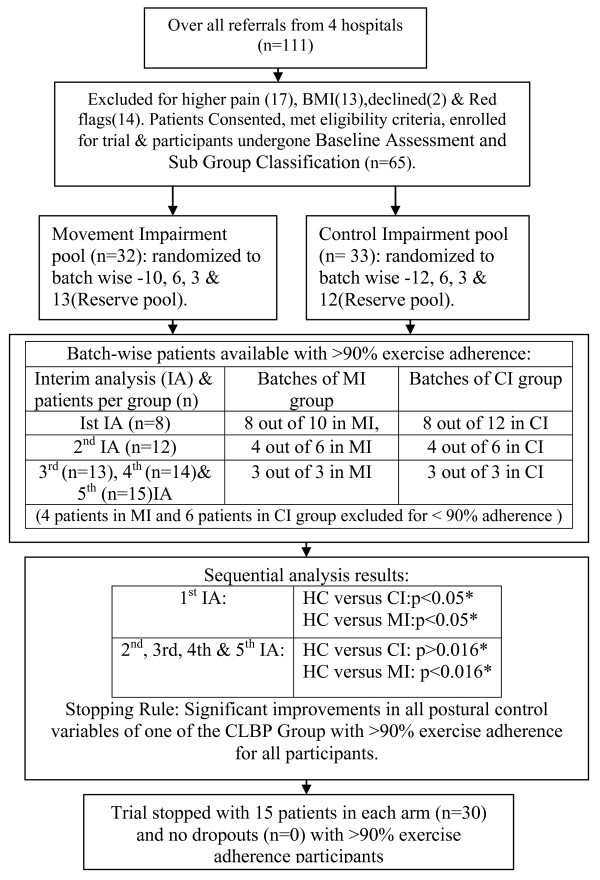
Flowchart of participant recruitment, retention & interim analyses; *p < 0.05 and p < 0.016: Armitage-McPherson adjusted critical p values based on no. of interim analyses (k) i.e., for first and fifth interim analyses respectively.